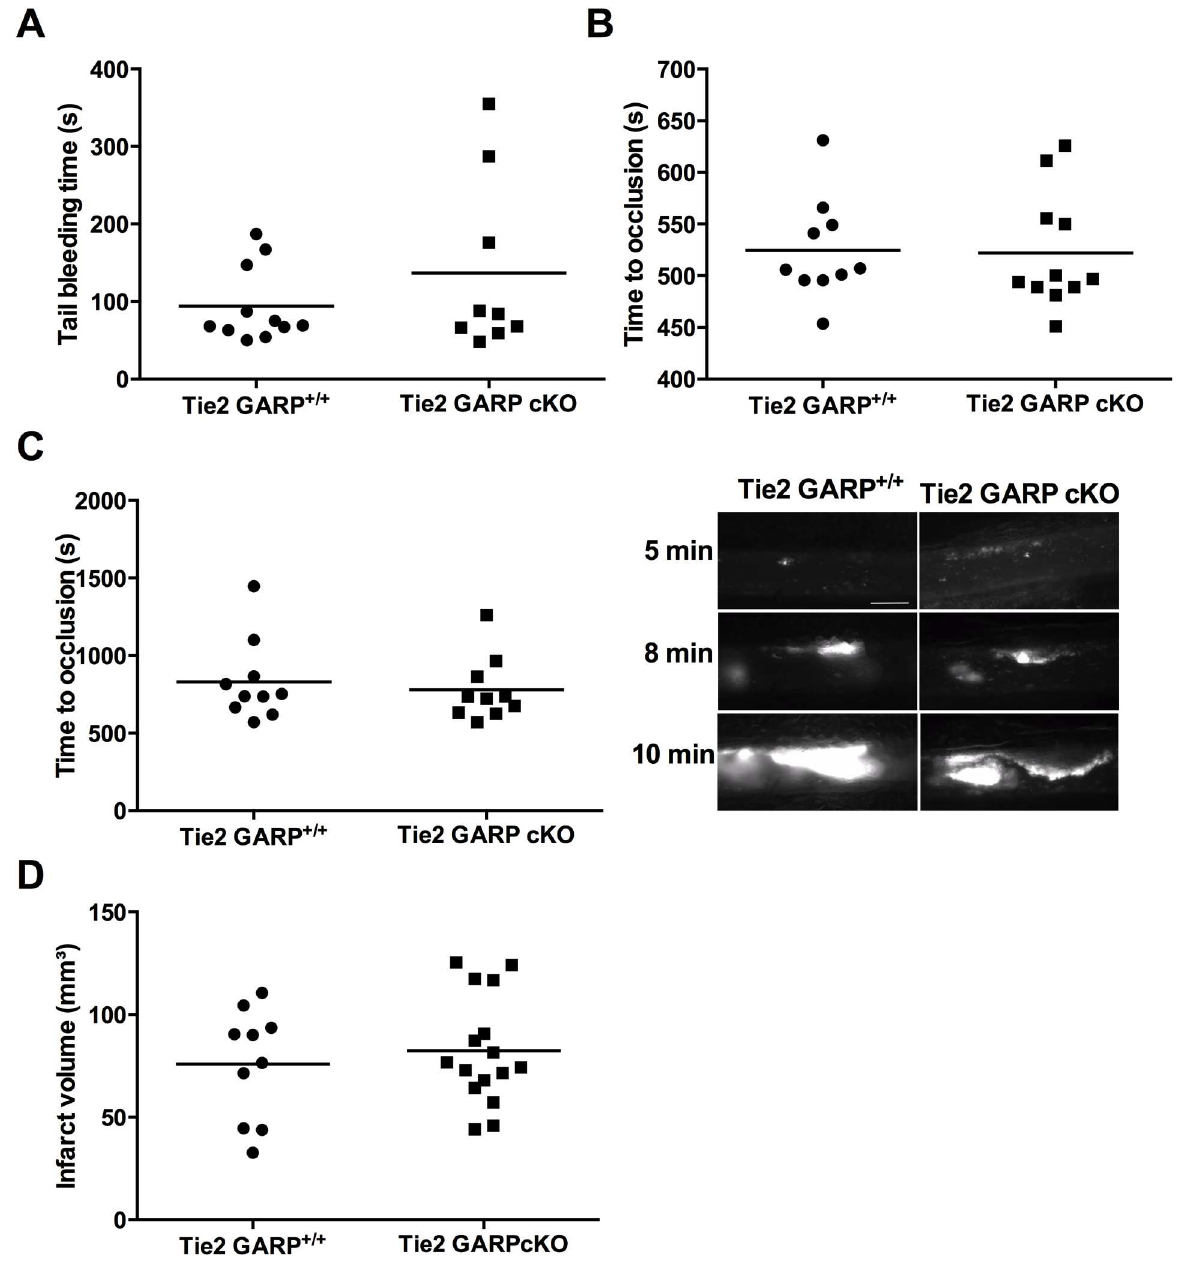
Fig 6. Unaltered bleeding time and thrombus formation in Tie2 specific GARP cKO mice. ( A ) 2 mm of the tail tip was dissected and tail bleedingtimes were measured(controls: n = 11; cKO: n = 9). ( B ) Carotidartery was injuredusing topicalapplicationof 12% FeCl 3 and blood flow was monitored using a flow probe until flow stoppeddue to the formation of an occlusive thrombus (controls: n = 10; cKO: n = 11). ( C ) Mesenteric arteries were injuredusing 10% FeCl 3 and thrombus formation was followedusing intravital microscopy until full occlusionwas reached(controls: n = 10; cKO: n = 11). Representative pictures after 5, 8 and 10 min of mesenteric thrombus formation are shown on the right. Scale bars represent 50 μ m. (D) The right middlecerebralartery of littermate mice (n = 10) and endothelium specific GARP knockout mice (n = 16) was occludedduring60 min and reperfusion was allowedduring23